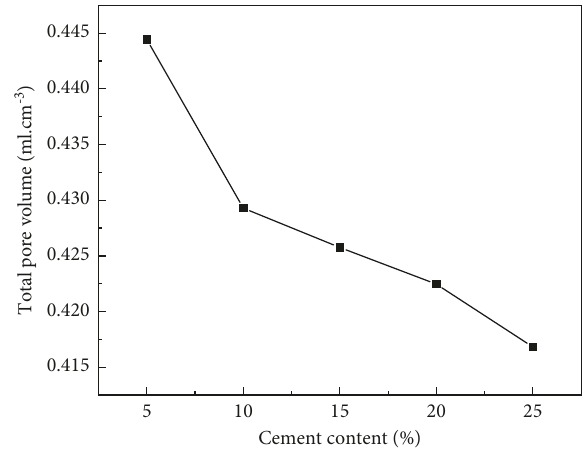
Figure 14: Relationship curve between total pore volume per unit volume cement soil and cement